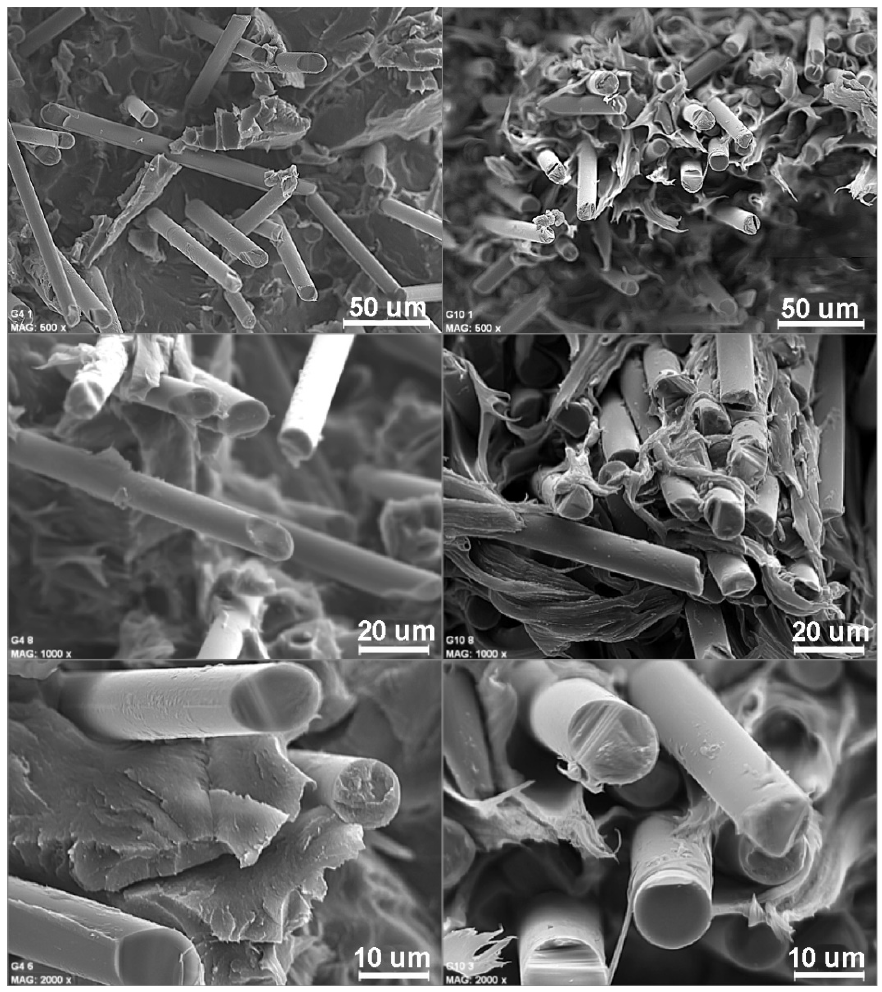
Figure 2. Scanning electron microscopy (SEM) of samples of PBT B 4300 G4 (left side) and PBT B 4300 G10 (right side) with magnitude amplification (500×, 1000×, and 2000×).